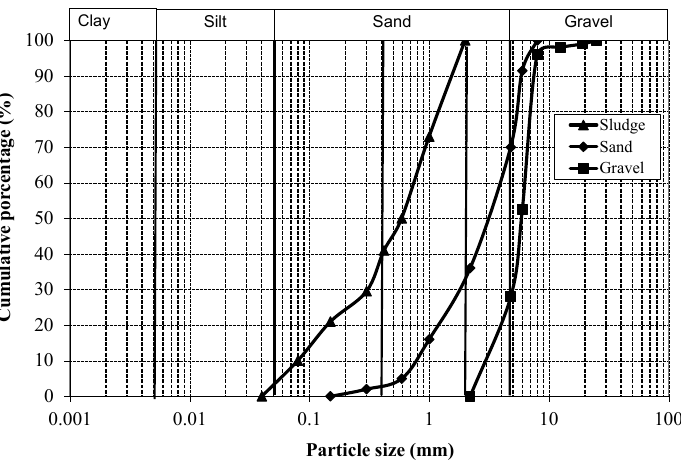
Figure 5. Particle size distribution of the aggregates.